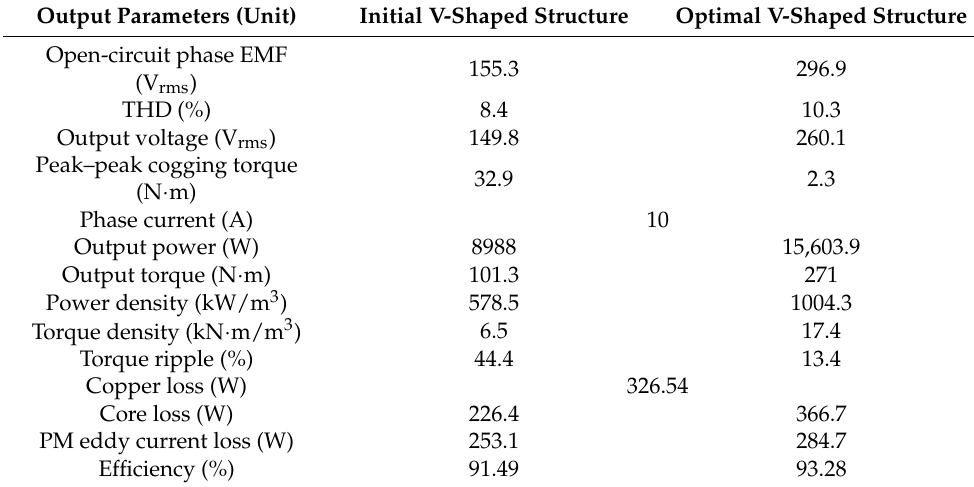
Figure 11. Comparison of electromagnetic torque waveform. Table 2. Performance comparisons at the rated speed of 500 rpm.